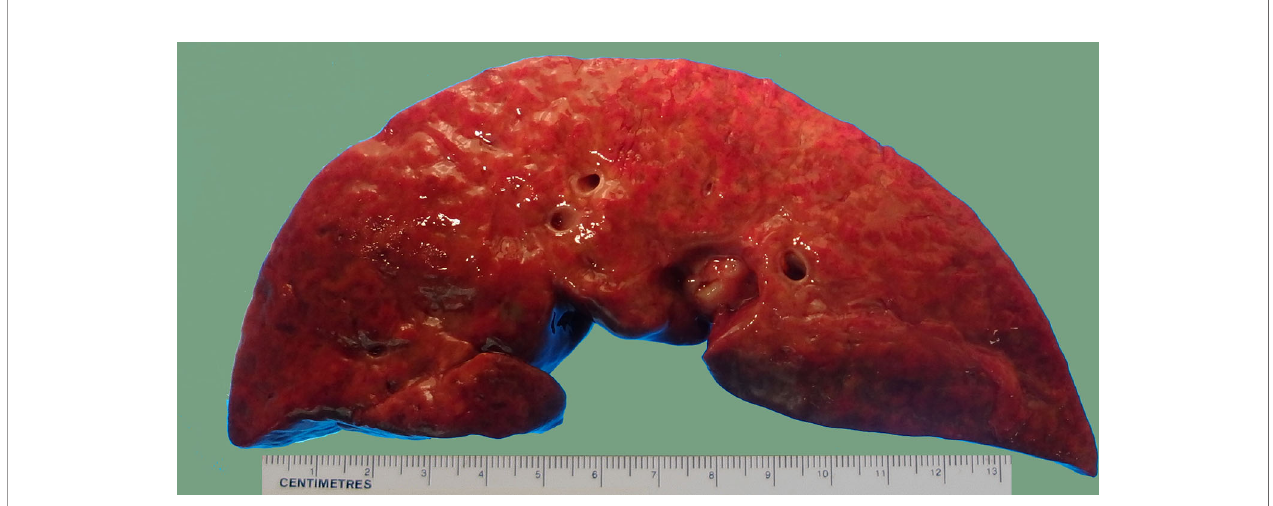
FIGURE 1 | Gross photograph of a liver with fulminant hepatic failure. Note the bosselated appearance with wrinkling of the capsule and mottling cut surface due to intermingled red and yellow areas. No atresia of the extrahepatic biliary system was found by careful examination of the